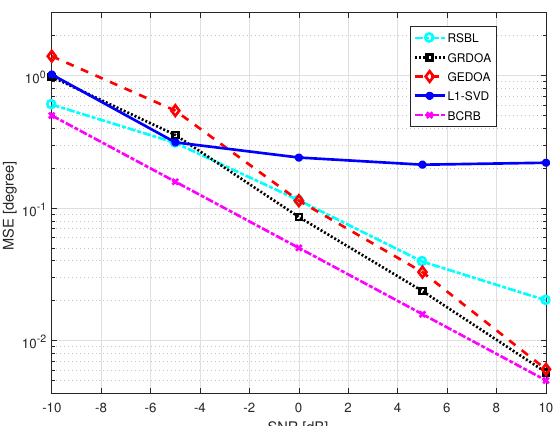
Figure 10. MSE of DOA estimation versus SNR. Two uncorrelated sources uniformly come from intervals of [ − 30 ◦ , − 20 ◦ ] and [ 0 ◦ ,10 ◦ ] .